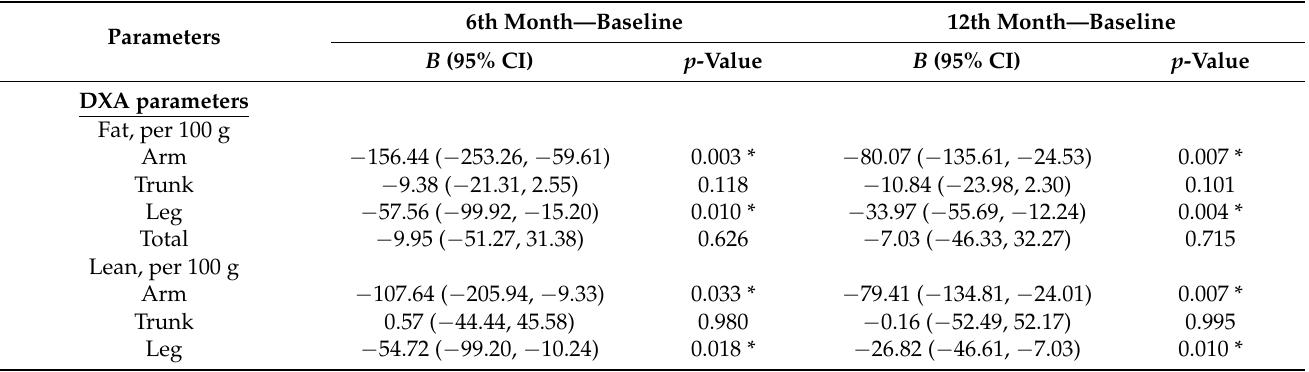
Table 6. The association between change of body composition and change of PSA in the exercise